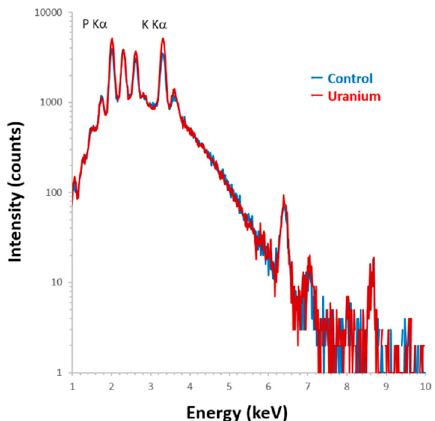
Figure 3. Particle-induced X-ray emission (PIXE) spectra obtained from scanning at position 7 in Figures 1E and 1F. Blue line, control; red line, uranium-treated; scanning area, 250 µ m × 250 µ m,